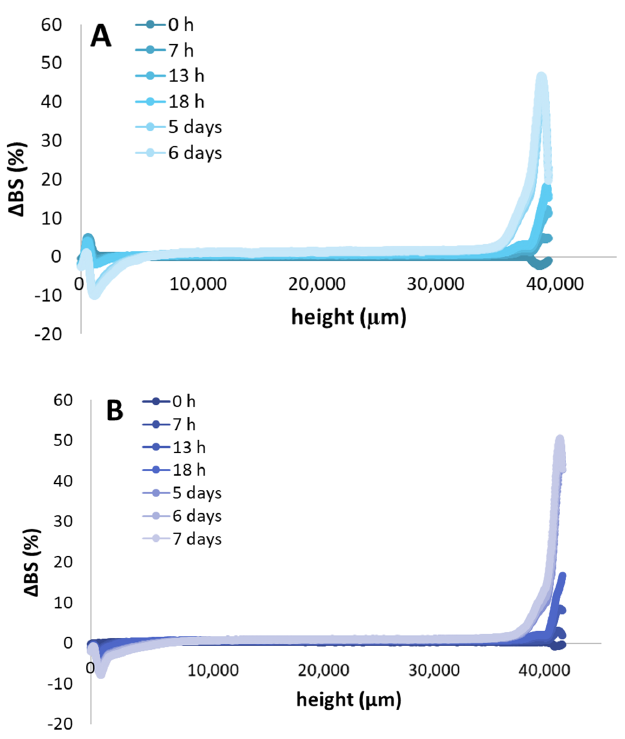
Figure 2. Turbiscan stability index (TSI) as a function of time (days), for Sigma and Norland (A ( - ) and B ( - )) and C ( - ), D ( - ), and E ( - ).